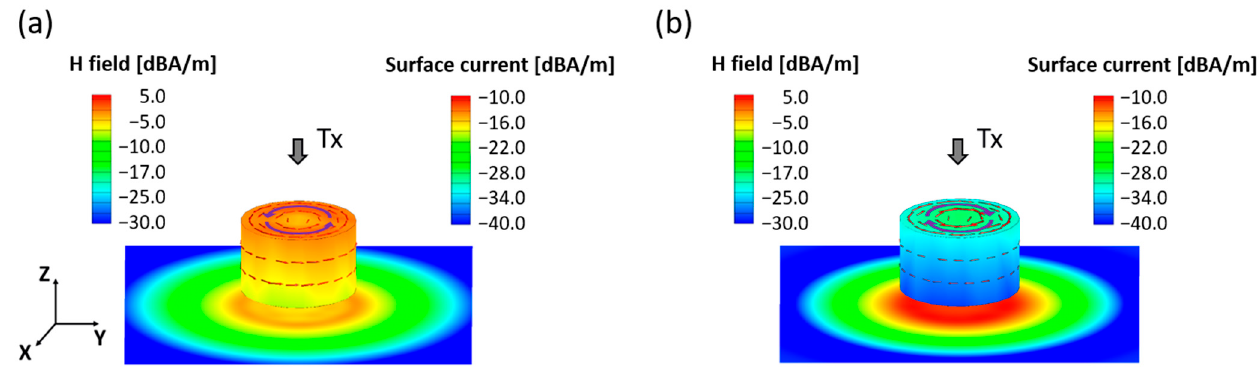
Figure 3. 𝐻 field and surface current with a different relative permeability of ( a ) 1 and ( b ) 1000 for cylinder materials at 50 Hz case. All cylinder materials have 10 6 S/m conductivity with a 0.2 m radius and height. The center of the cylinder at the bottom ( 𝑧 = 0 ) is 𝑥 = 𝑦 = 0 .